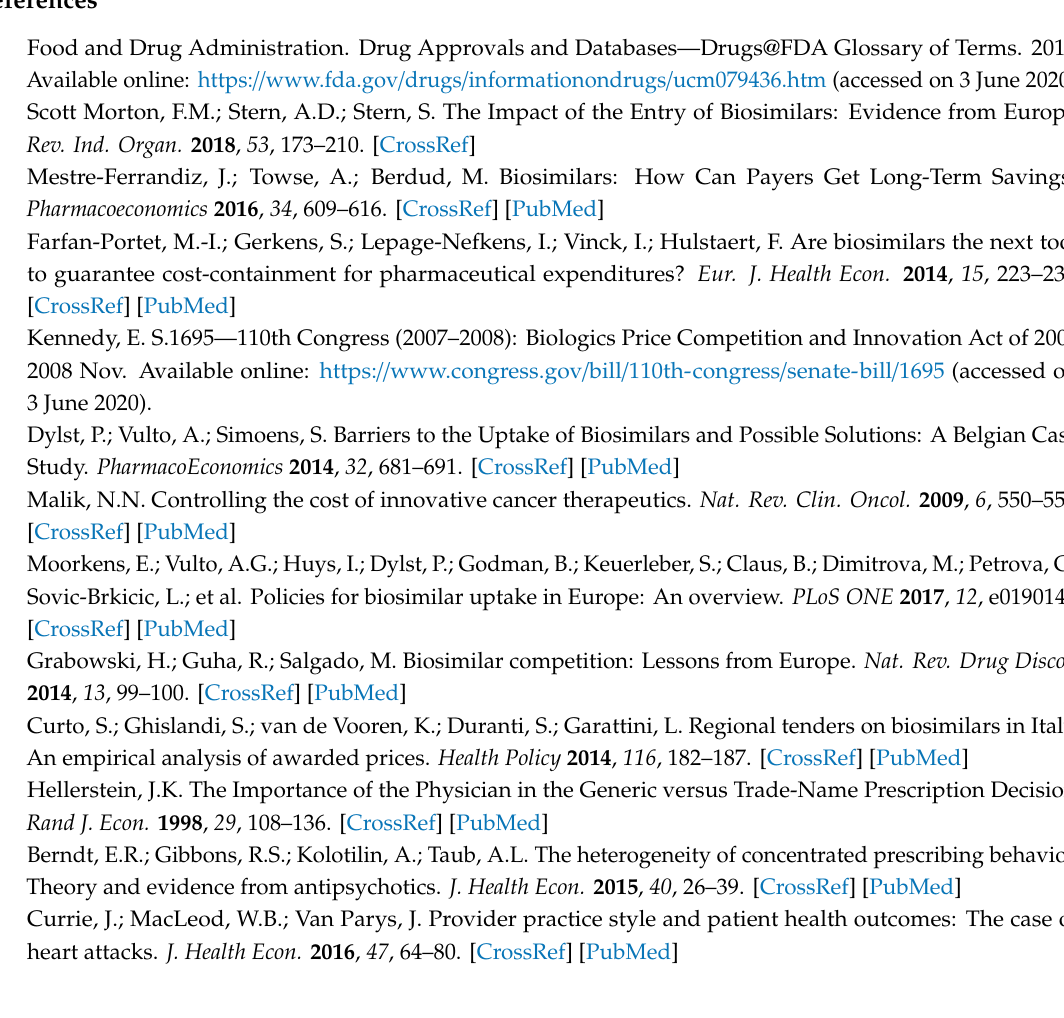
Table S1: Identification of drug agreements for biosimilar prescribing, web search and contact with physician associations. Table S2 Number of physician practices with biologic prescriptions 2013. Table S3: Cost-control measures for biosimilars by physician associations, 2009–2015, ESA. Table S4 Cost-control measures for biosimilars by physician associations, 2009–2015, filgrastim. Table S5 Cost-control measures for biosimilars by physician associations, 2009–2015,